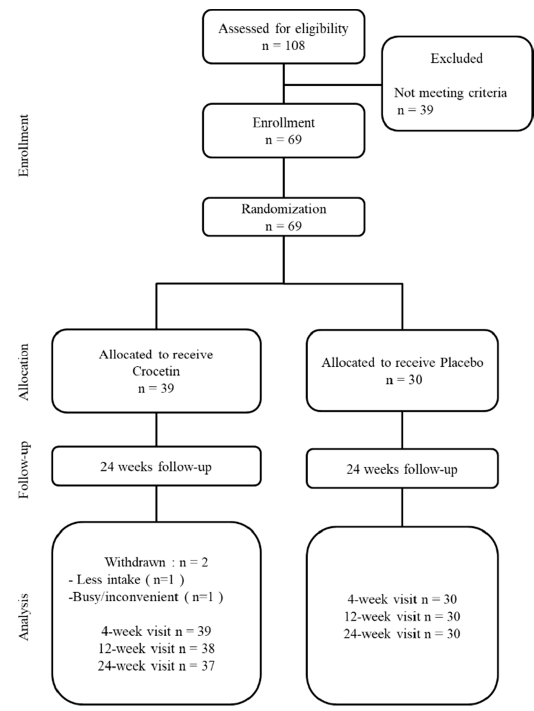
Figure 1. Flowchart of this double-blind randomized clinical trial time points and number of participants. Figure1.